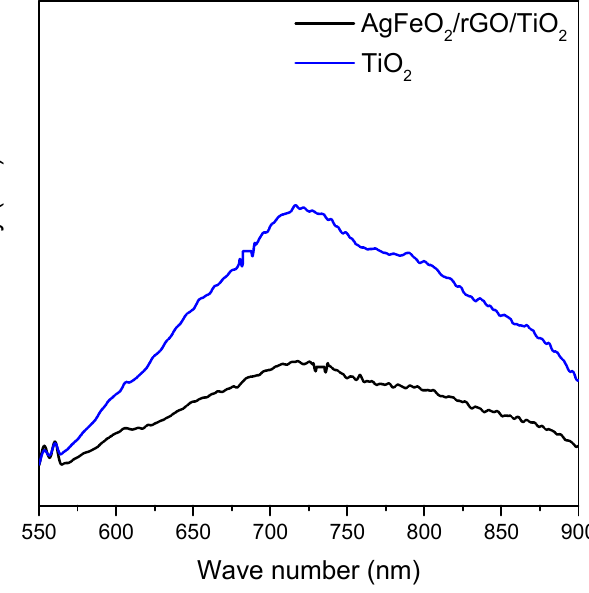
Figure 4. PL spectra of TiO 2 and 2.5% AgFeO 2 / rGO / TiO 2 .